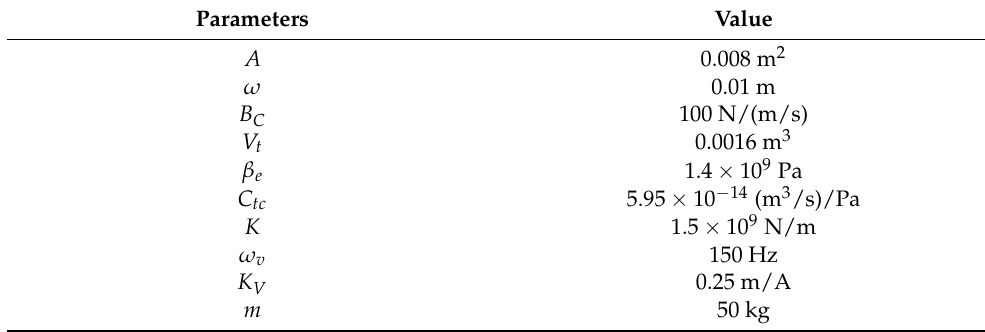
Figure 6. Comparison of step output between identification model and actual system. Table 1. System parameter table.